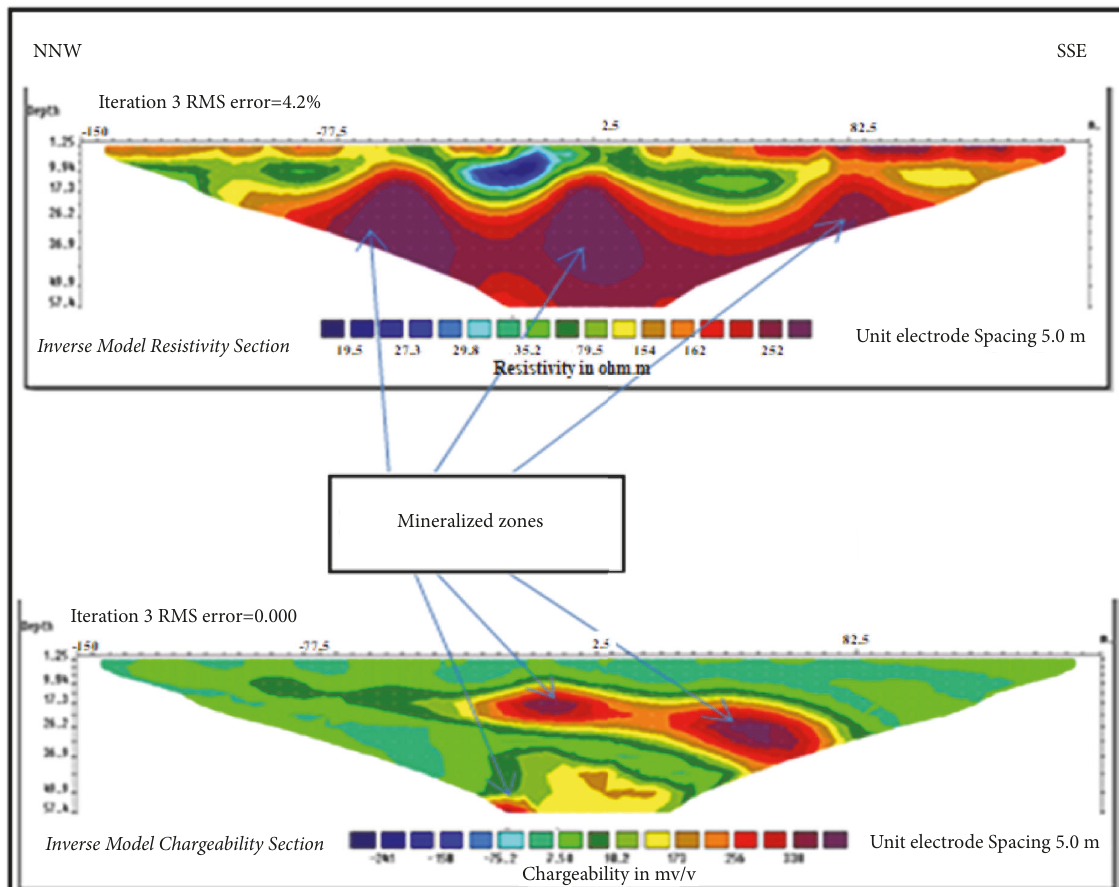
Figure 12: Inverse model resistivity and chargeability sections (Tabesbaste 2; direction: